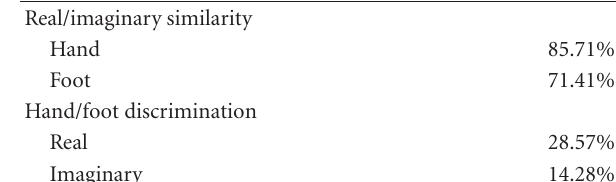
Table 1: Real/imaginary statistical similarity and hand/foot dis- crimination percentages of subjects using t -test comparisons ( P > 0 . 05) of ERD/ERS values: our subjects showed high performance in Foot and Hand Motor Imagery but low source